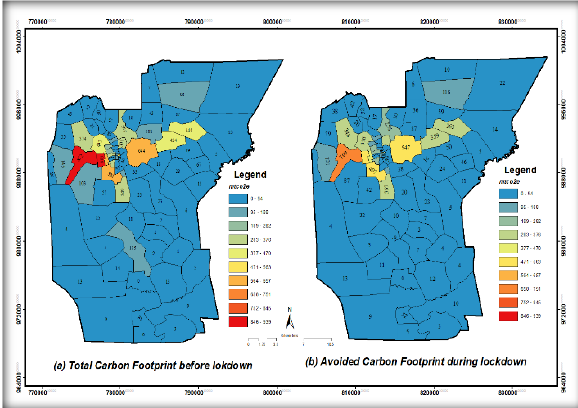
Figure 14. Spatial distribution of carbon (CF) impacts across 86 barangays areas in Butuan City: (a) Total carbon footprint calculated during pre- lockdown period (b) The carbon footprint impact saved during the lockdown period a